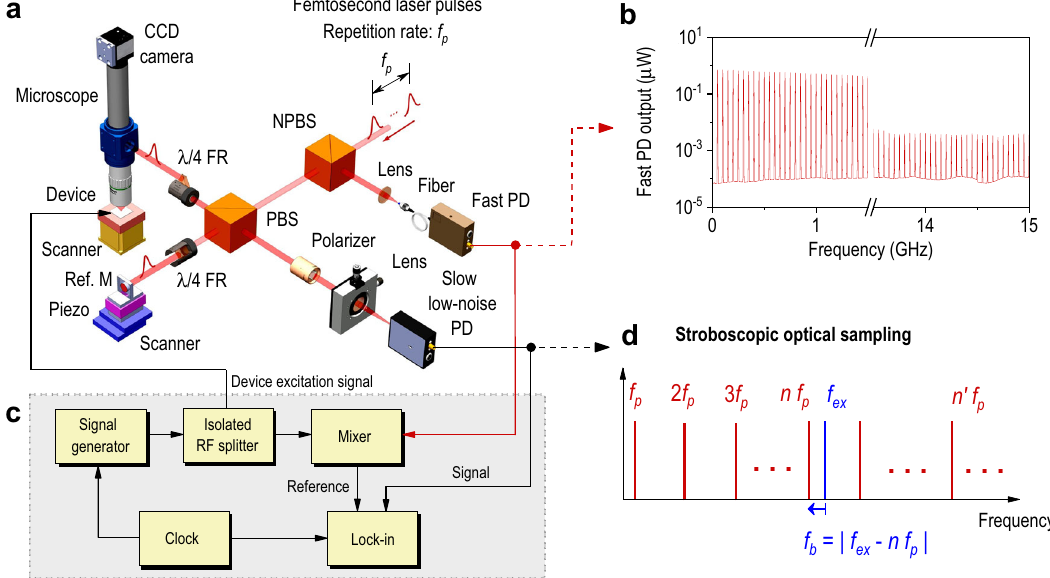
Fig. 1 Instrument for stroboscopic optical sampling. a Schematic layout of the optical set-up. NPBS non-polarizing beam splitter, PBS polarizing beam splitter, PD photodetector, Ref. M reference mirror, λ /4 FR quarter-wave Fresnel rhomb (45° polarized), Piezo piezoelectric nanopositioner. The laser is collimated and 45° polarized before entering the NPBS. λ /4 FRs are used to manipulate laser polarization due to their wide spectral fl atness. b Electrical spectrum of the laser pulse train obtained by directly measuring a split of the ultrafast laser using a fast PD (12.5 GHz bandwidth) and a wide-band spectrum analyzer, showing an RF frequency comb with teeth equally spaced by the laser repetition rate, f p . c Schematic layout of the electronics for device excitation, lock-in reference generation, and signal detection. d Schematic explanation of stroboscopic optical sampling in the frequency domain where beating the excitation signal, f ex , with the RF comb using the tooth at nf p , results in a low-frequency beat note at f b